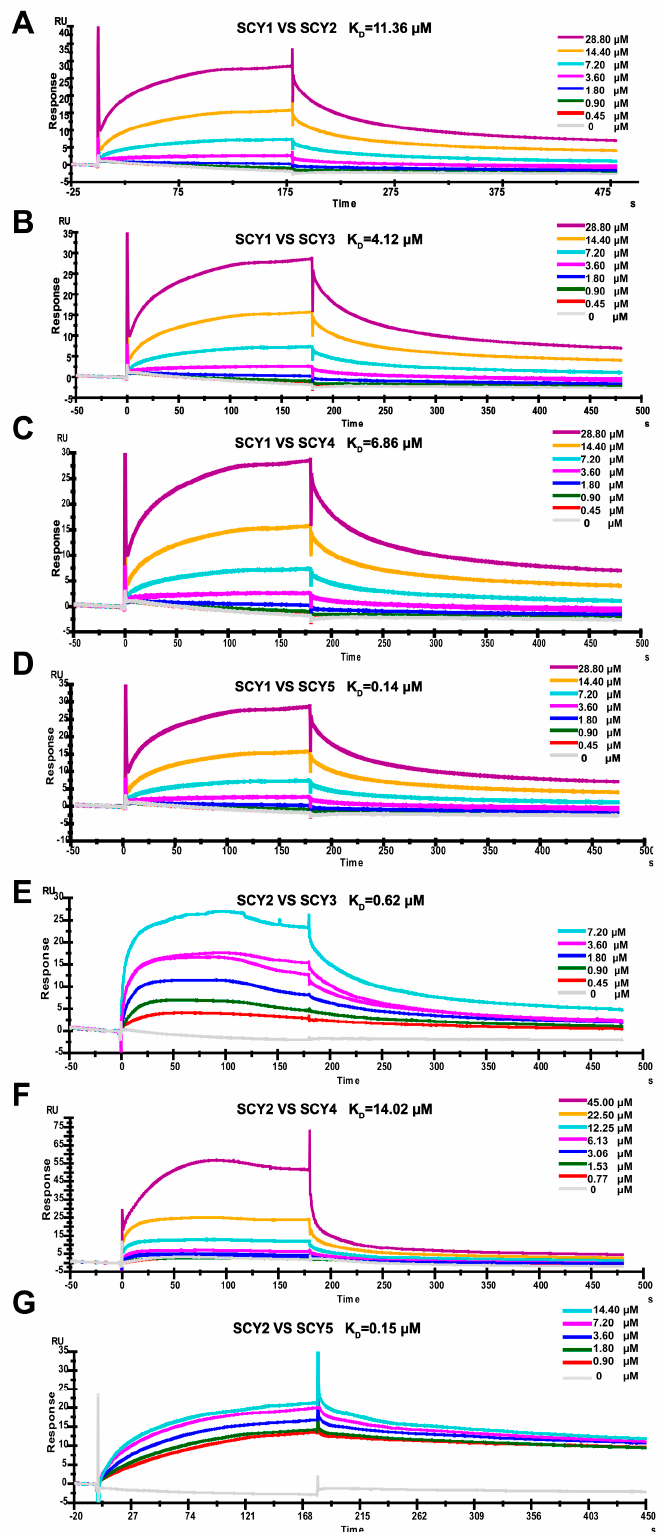
Figure 5. Binding kinetic between rSCY1 and rSCY2 ( A ); rSCY1 and rSCY3 ( B ); rSCY1 and rSCY4 ( C ); rSCY1 and rSCY5 ( D ); rSCY2 and rSCY3 ( E ); rSCY2 and rSCY4 ( F ); rSCY2 and rSCY5 ( G ), assessed by surface plasmon resonance (SPR, a technology for detecting interactions between biomolecules using biosensor chips)